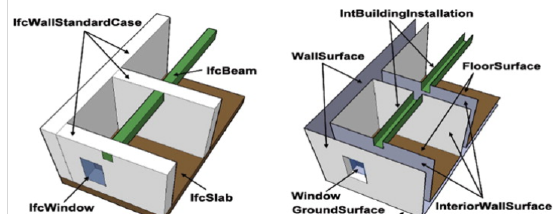
Figure 2: Semantics of IFC and CityGML (Nagel, Stadler & Kolbe,